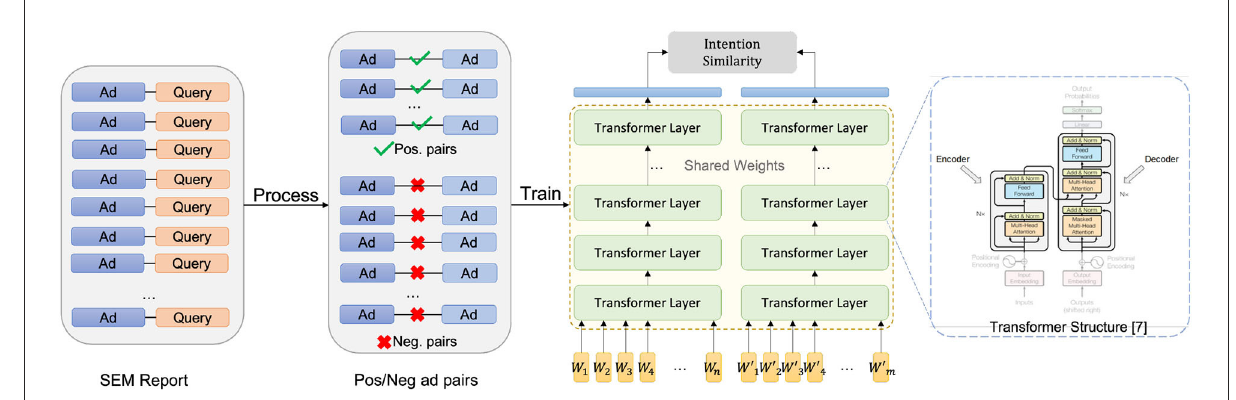
FIGURE3 Search engine marketing ads customer intention embedding model and its training